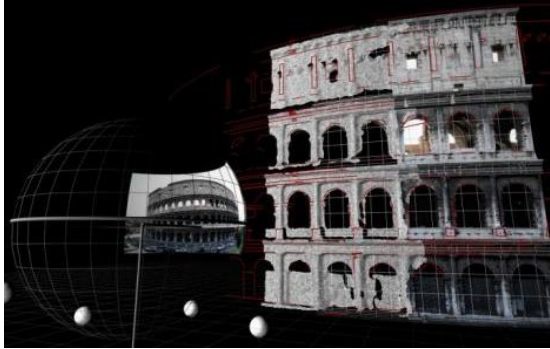
Figure 16. Photo-realistic surfaces reconstruction